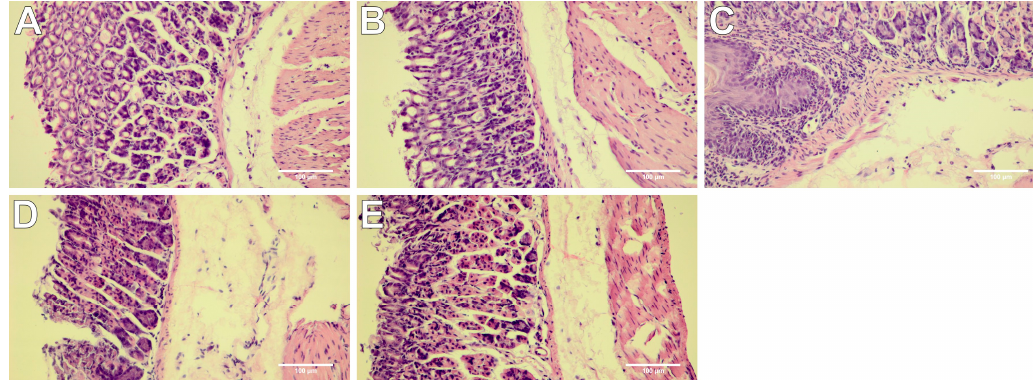
Figure 6. Microscope appearance of stomach tissue after hematoxylin-eosin (H&E) staining demonstrated that studied compounds neither altered the normal stomach architecture nor induced ulcerations. Morphine and indomethacin were used as reference drugs. Experimental groups ( n = 12): Control group ( A ); group receiving 10 mg/kg morphine ( B ); group receiving 10 mg/kg indomethacin ( C ); group receiving 20 mg/kg compound 10b ( D ); group receiving 20 mg/kg compound 13b ( E ); magnification 200×. Table 1. The impact of compounds 10b and 13b on gastric mucosa. Morphine and indomethacin were used as reference drugs. Experimental groups ( n = 12): C—control group; M—group receiving 10 mg/kg of morphine; I—group receiving 10 mg/kg of indomethacin; 10b -5, 10b -10, 10b -20—groups receiving, respectively, 5, 10, or 20 mg/kg of investigated compound 10b ; 13b -5, 13b -10, 13b -20—groups receiving, respectively, 5, 10, or 20 mg/kg of investigated compound 13b . Scoring scale of macroscopic evaluation of gastric mucosa: (0) = no damage; (1) = 1–4 small petechiae; (2) = 5 or more petechiae or hemorrhagic streaks up to 4 mm; (3) = erosions longer than 5 mm or confluent hemorrhages. Scoring scale of microscopic evaluation of gastric mucosa: (0) = no damage; (1) = mild changes; (2) = moderate changes; (3) = severe changes. Data are presented as mean values ± SEM. Differences ^^^ p < 0.001 vs. the control group; *** p < 0.001 vs. the indomethacin group were deemed statistically significant.